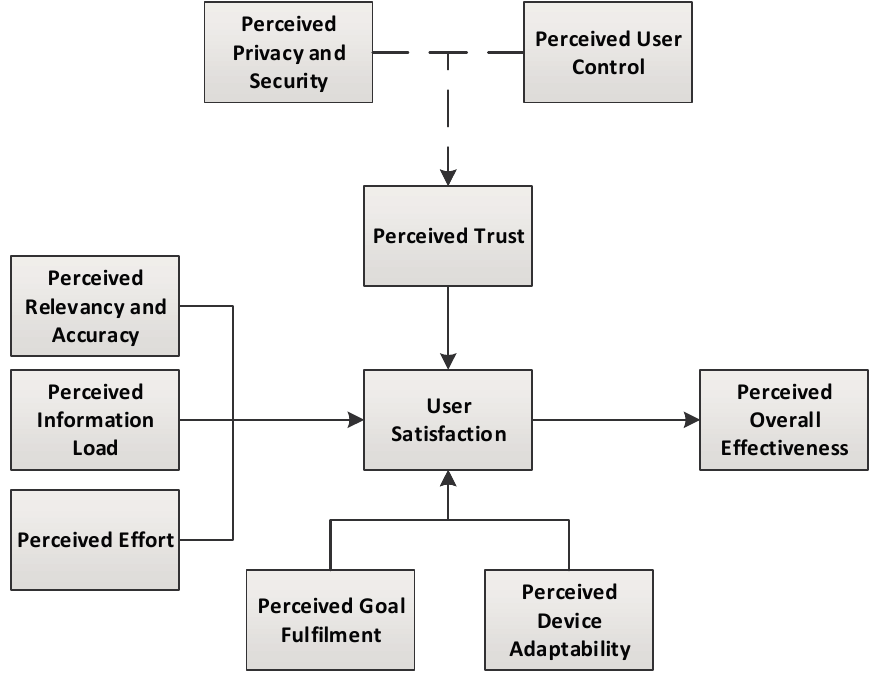
Figure 7. Evaluation model for PSDs based user-centric personalization